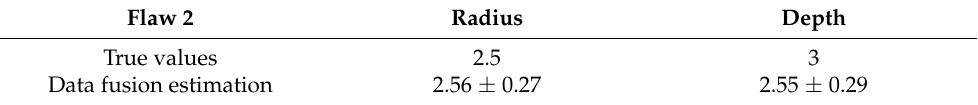
Table 3. ANNs estimations of radii and depths (mm) obtained for the second measured flaw.